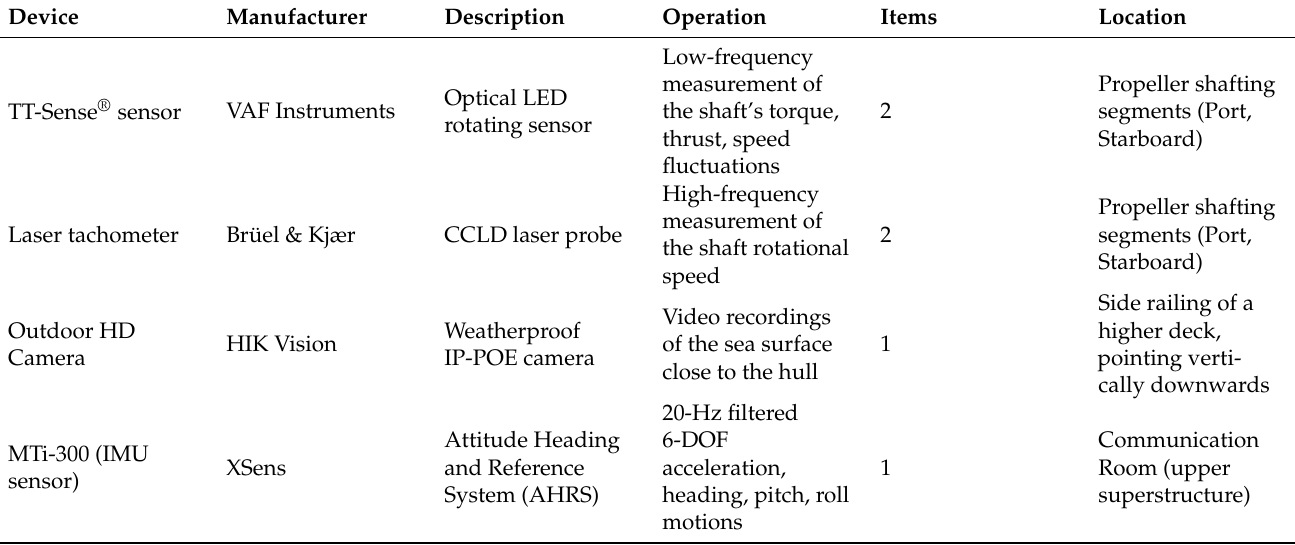
Table 1. Outline of the measurement system components.